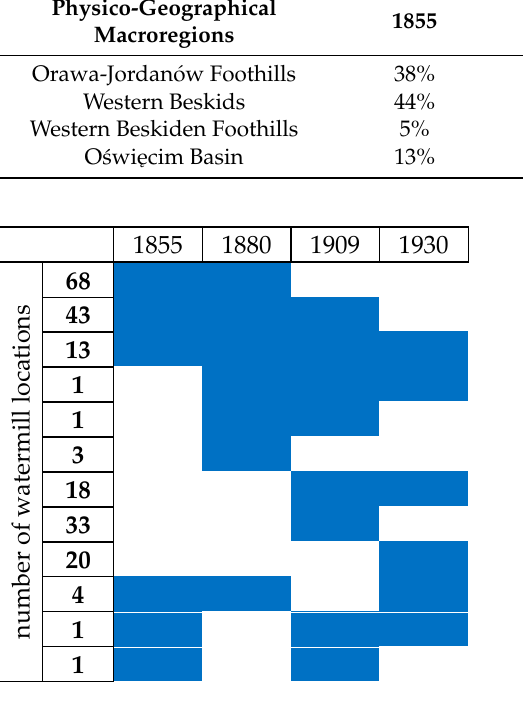
Figure 3. The continuity of operation of watermills in the River Skawa catchment in the period 1855–1930. Blue cells represent a period of uninterrupted work.